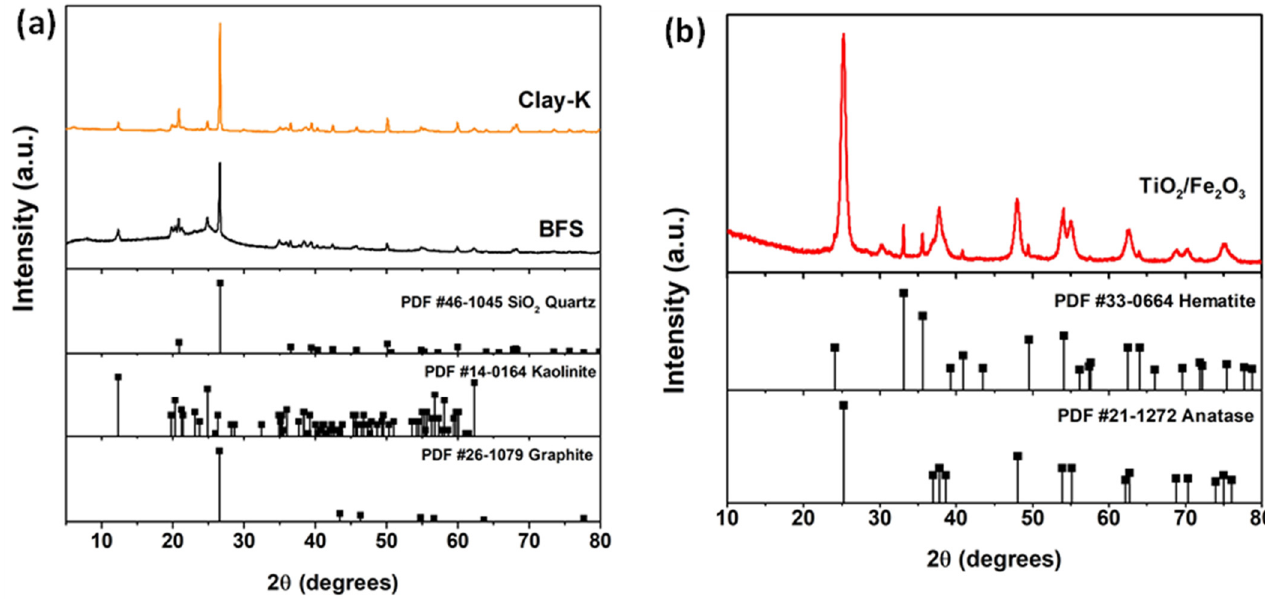
Figure 4. X-ray diffractograms of ( a ) BFS and Clay-K samples and of ( b ) TiO 2 /Fe 2 O 3 sample. Diffraction patterns of quartz (PDF # 46-1045), (kaolinite (PDF # 14-0164), graphite (PDF # 26-1079), anatase (PDF 21-1272), and hematite (PDF 33-0664) are included.